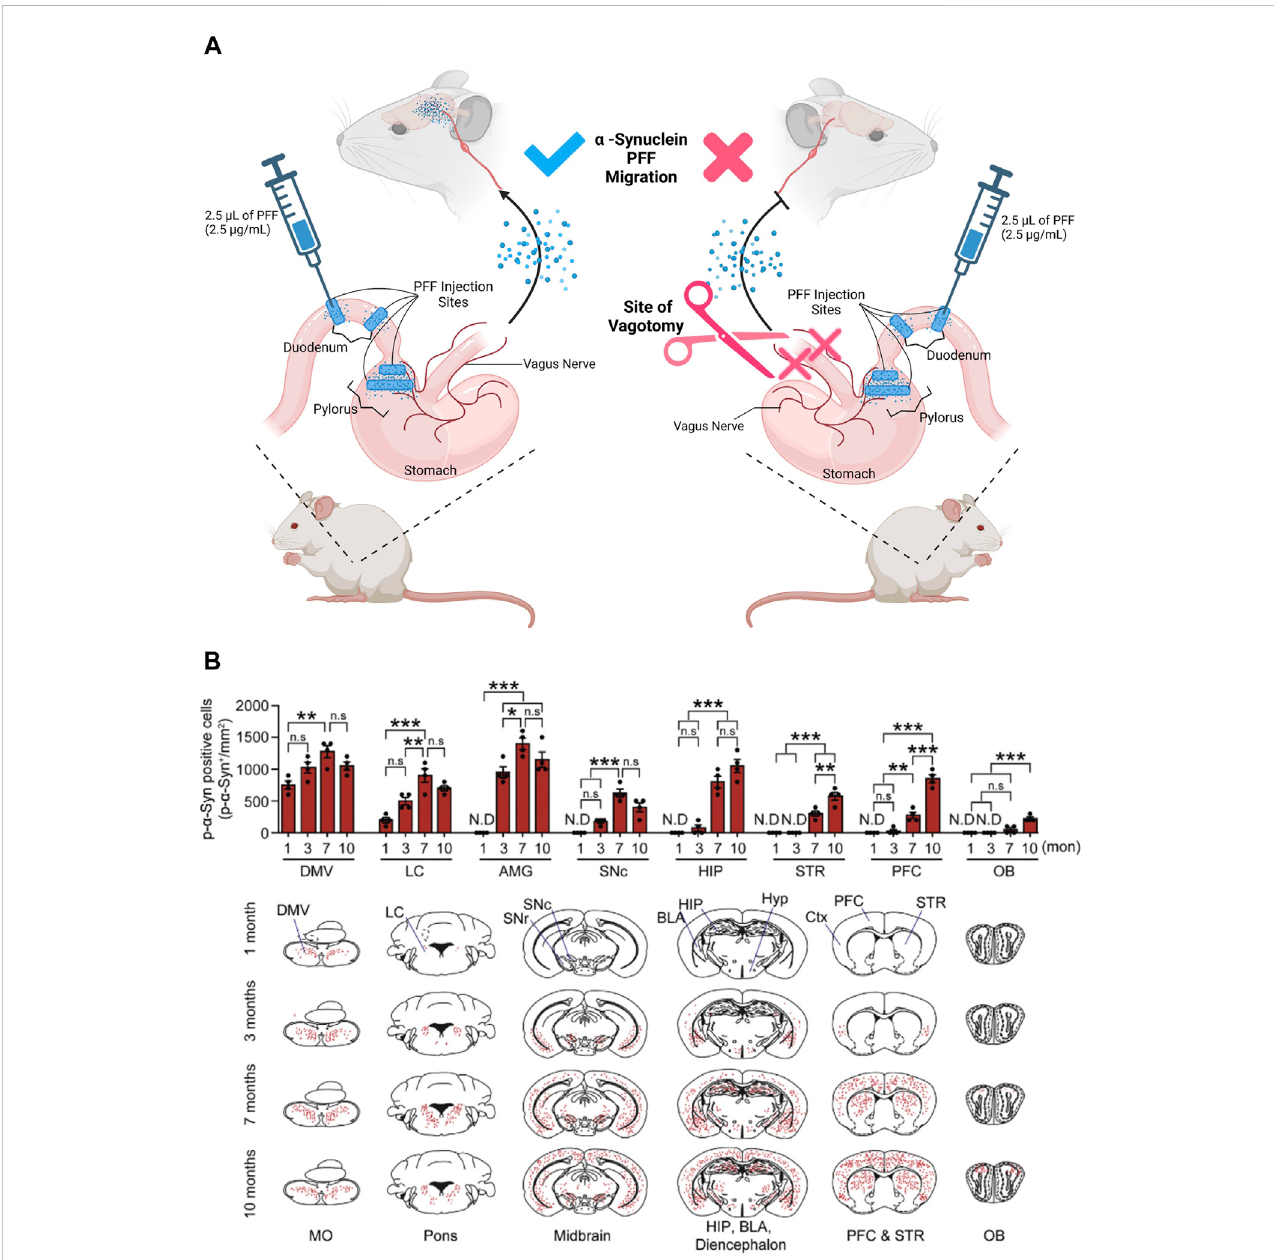
FIGURE 2 α -Synucleinprogressivelytranslocatesfromthegutintothebrain:experimentaldiagramandresult. (A) PFFsPathologic α -Synuclein(pSer129- α -syn),as Pre-Formed Fibrils (PFFs), were injected into the duodenum and pylorus of a mouse. Translocation of Pre-Formed Fibrils (PFFs) of Pathologic α -Synuclein fromtheuppermostdivisionofthesmallintestinewasfacilitatedbythenodoseganglion(thevagalnerveafferentsofthemouse).Tocon fi rmthecredibilityof this migratory route, the anterior trunk of the vagal afferents were severed (site of vagotomy). PFFs were not identi fi ed in the brains of the mice that received an anterior trunk vagotomy. (B) The graphs represent the progressive translocation of PFFs from the gut into the brain after 1 – 10 months from the injection. At month one post injection, the α -Synuclein PFFs translocates into the brain, fi rst appearing at the Medulla Oblongata (MO). The trans-neuronal propagation and migration of the PFFs into the mouse brain proceeded from the posterior MO to the mouse brain ’ s anterior Olfactory Bulb (OB) (MO to OB). Within 1 monthpostinjection, PFFsweredetectedintheDorsalMotor Nucleus oftheVagus nerve(DMV)oftheMO, andLocus Coeruleus (LC)ofthePons.At 3 months post injection, the abundance of PFFs in the Amygdala (AMG) spiked, while trace amounts of PFFs in the substantia nigra para compacta (SNc), Hippocampus (HIP), and Pre-Frontal Cortex (PFC) were detected. At 7 months post-injection, PFFs were detected in the Striatum (STR) and olfactory bulb (OB). Finally, at 10 months PFF has in fi ltrated and diffused through the entire brain. Data extracted and modi fi ed from (Kim et al., 2019). Figure constructed on